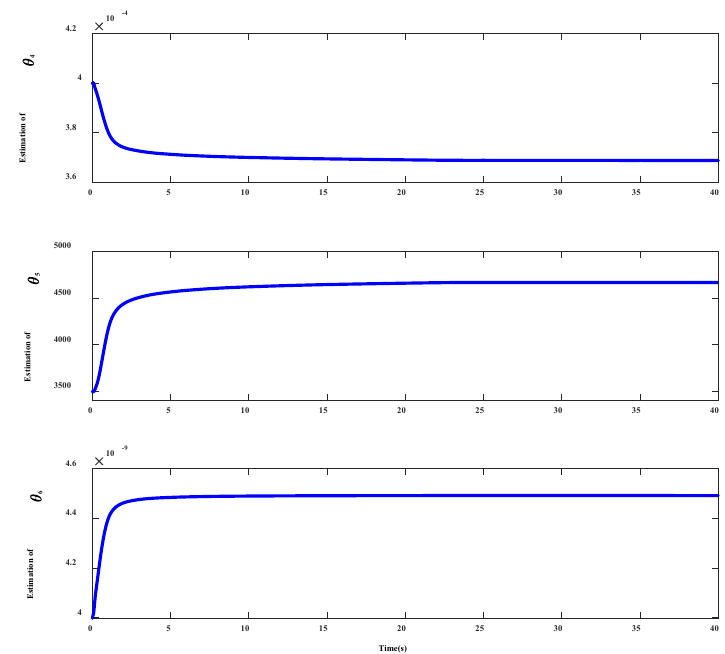
Figure 6. The parameter estimations of θ 4 ~ θ 6 with the ADRAC.